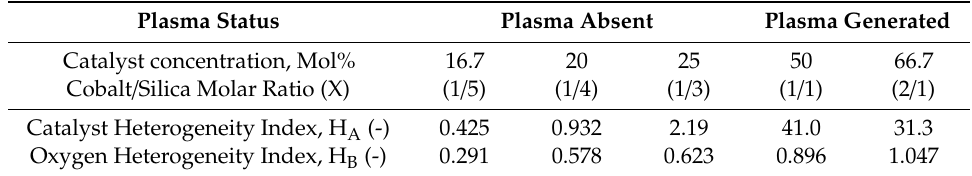
Table 9. Variation of Cobalt / Silica- and Oxygen-Heterogeneity indices, H A and H B with catalyst concentration for Co / Si = X catalyst in the absence or presence of plasma